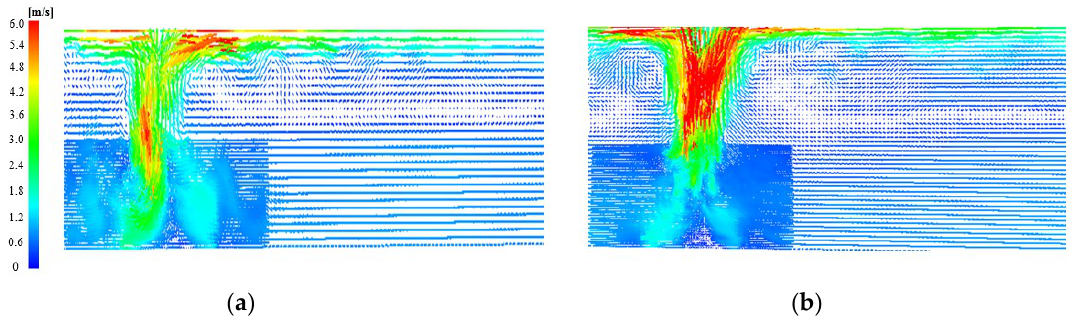
Figure 7. Velocity vector on longitudinal direction at 1500 s, ( a , b ) represent the tunnel aspect ratio of 0.36 and 1.39, respectively.